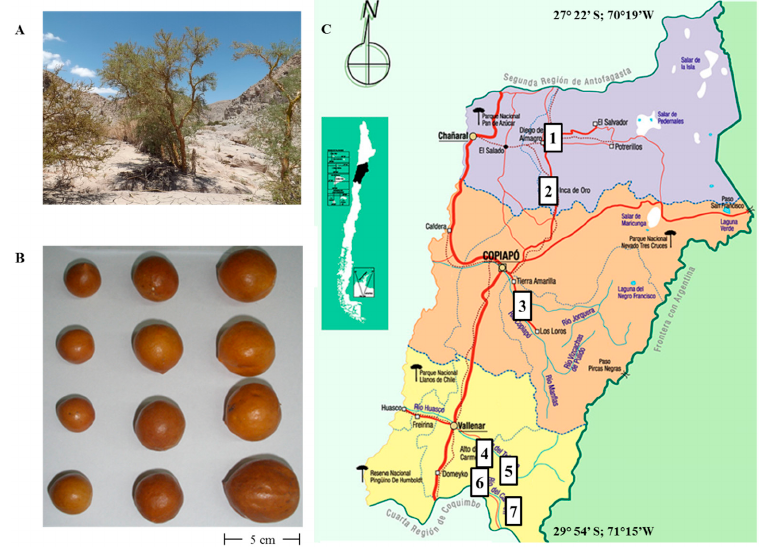
Figure 1. ( A ) Chañar tree ( Geoffroea decorticans ) growing in the Región de Copiapó; Chile ( B ) Different fruits showing variation in size ( C ) Map of Chile showing the Región de Atacama and the collection de Copiapó: (3) Copiapó (ripe and turning fruits); Provincia de Huasco: (4) Alto del Carmen; (5) El Copiap ó : (3) Copiap ó (ripe and turning fruits); Provincia de Huasco: (4) Alto del Carmen; (5) El Transito; Transito; (6) Pinte and (7) Conay. (6) Pinte and (7)